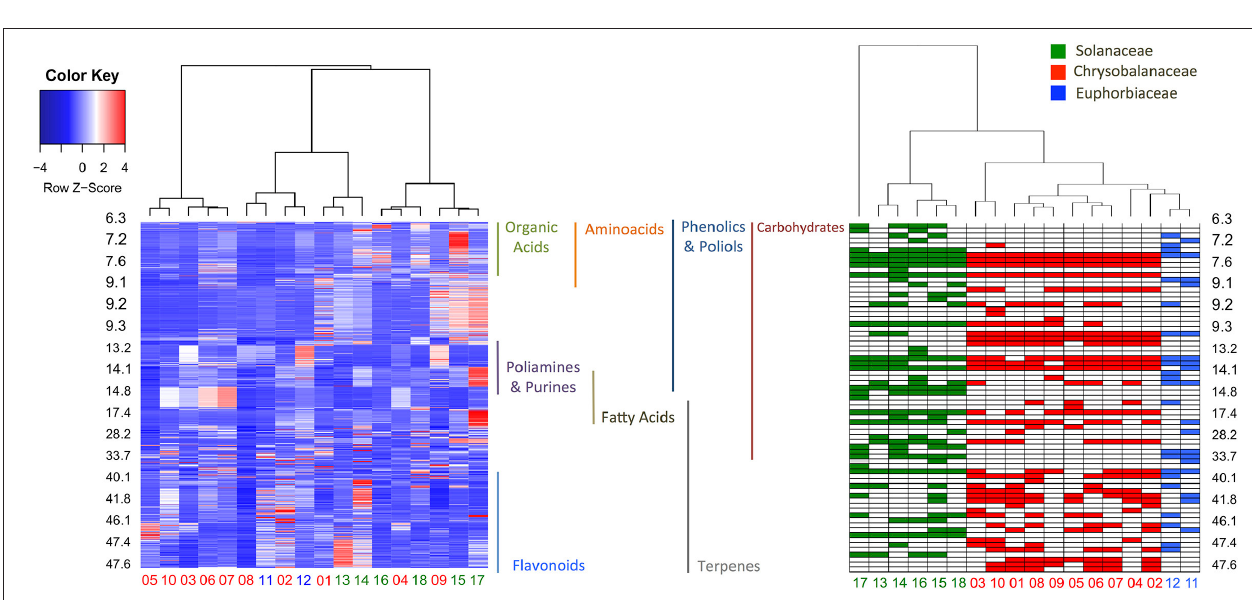
the deconvolution, resulting in increased MF values for each of the metabolites: α -tocopherol ( MF 900), octacosanoic acid = ( MF 870) and raffinose ( MF = =